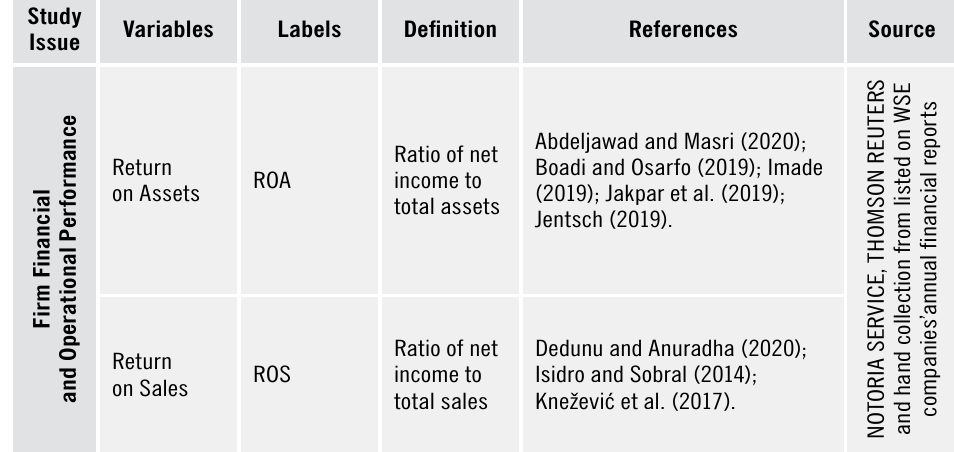
Table 1. Dependent